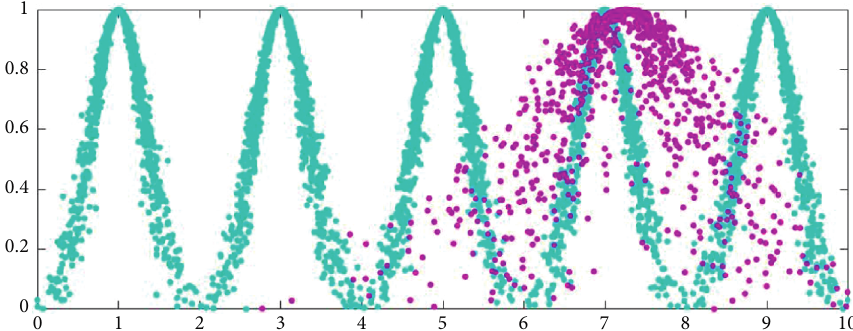
Figure 7: Comparison of standard cloud model and evaluation results cloud model